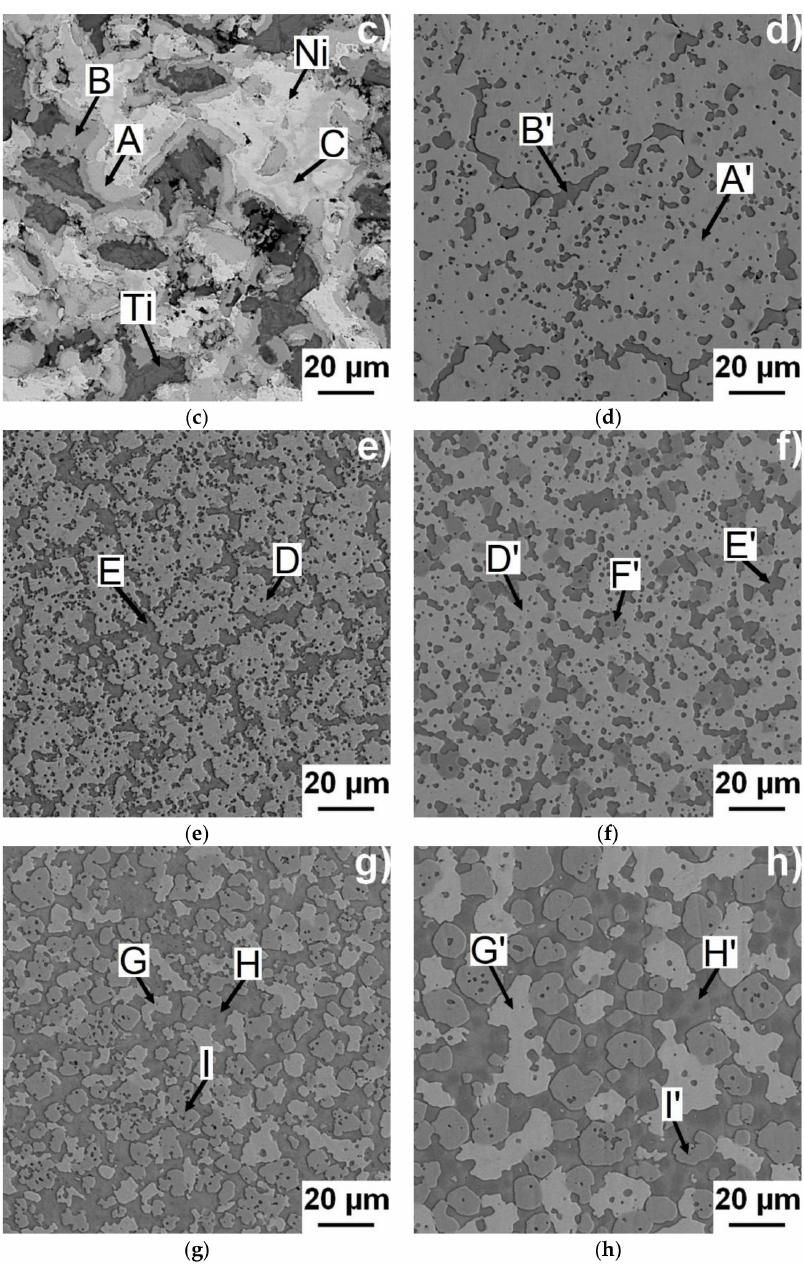
Figure 10. Microstructures of NiTi46 sintered at ( a ) 800 ◦ C and ( b ) 1100 ◦ C; NiTiAl3 at ( c ) 800 ◦ C and ( d ) 1100 ◦ C; NiTiAl5 at ( e ) 800 ◦ C and ( f ) 1100 ◦ C; and NiTiAl7 at ( g ) 800 ◦ C and ( h ) 1100 ◦ C. The labels of A–I and A’–I’ term places of chemical analysis stated in Table